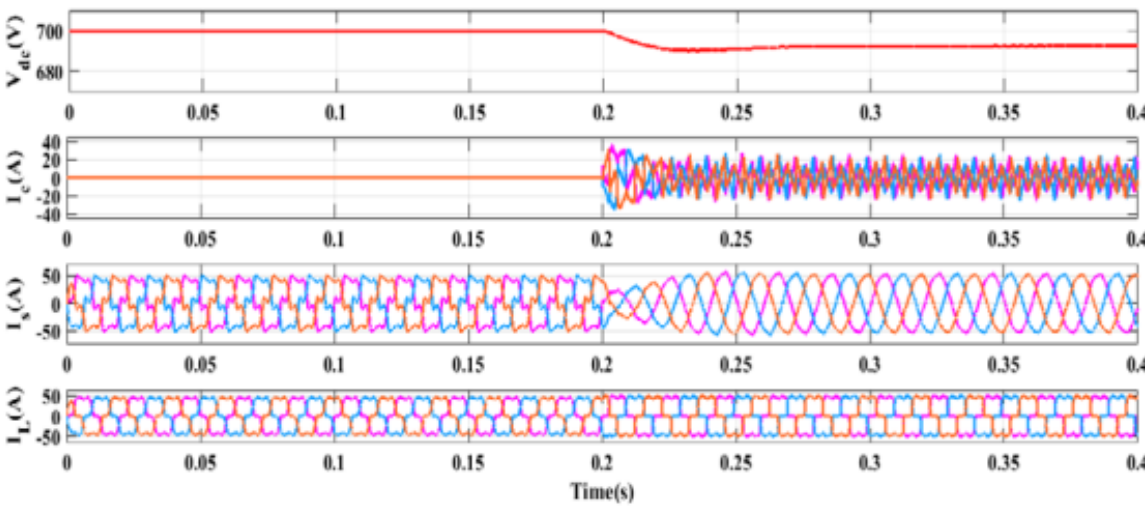
Figure 16. Performance of Icos θ control-based DSTATCOM under voltage-source non-linear